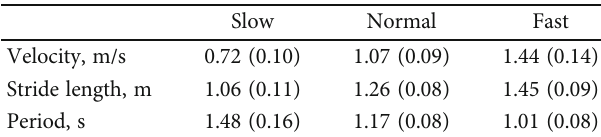
Table 1: Average and standard deviation of the gait parameters (velocity, stride length, and period) of measured walking